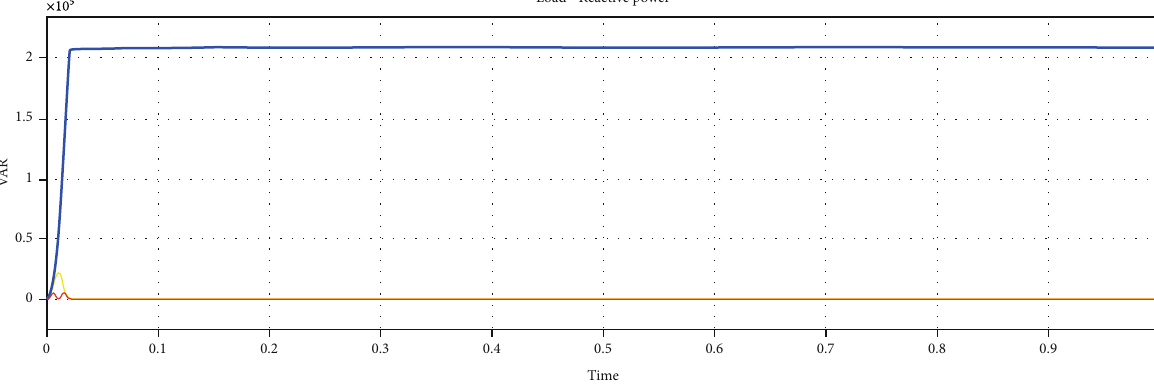
Figure 30: Reactive power consumed by the load.